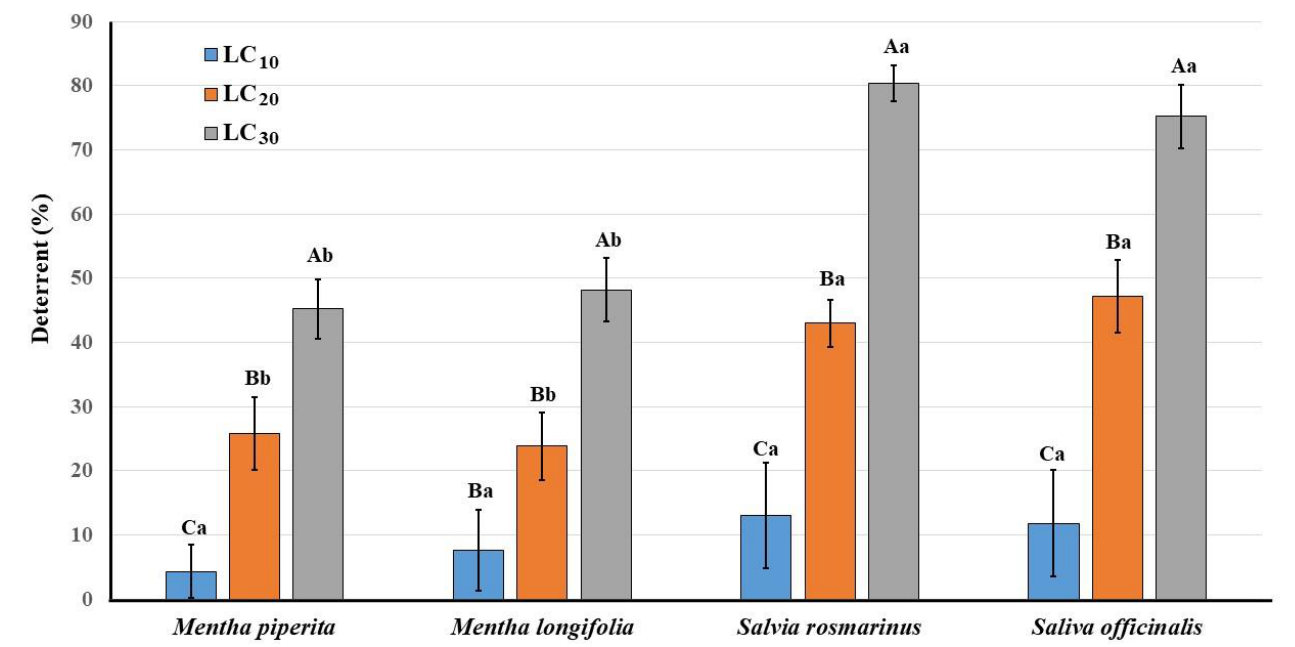
Figure 1. Deterrent effects (%) of the three lethal concentrations of tested four plant essential oils against imago of Aphis punicae. Different capital letters (among the lethal concentration of the same EO) and small letter (among EOs of the same lethal concentration) above bars indicate significantly different means according to Tukey’s test ( p < 0.05). Bars indicate the standard error (SE). Table 4. Two-Way ANOVA for deterrent activity of the tested four plant essential oils on A. punicae .